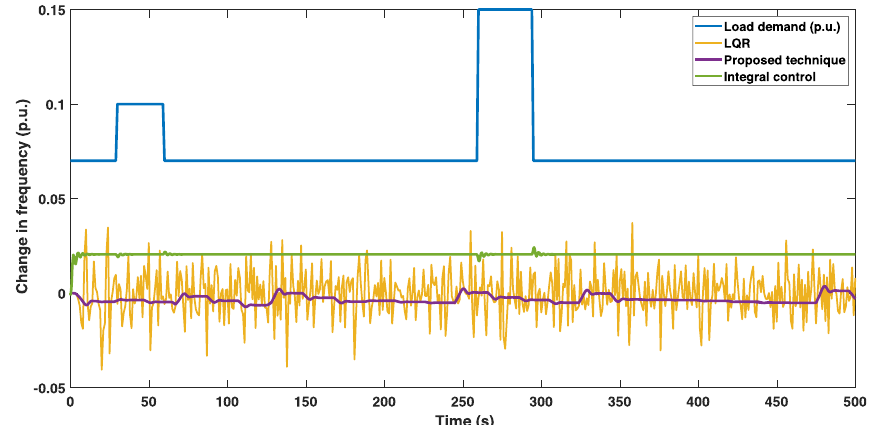
Fig. 13 Comparison of frequency deviation of the system considered with the application of integral control, LQR and proposed technique for a measurement noise variance of